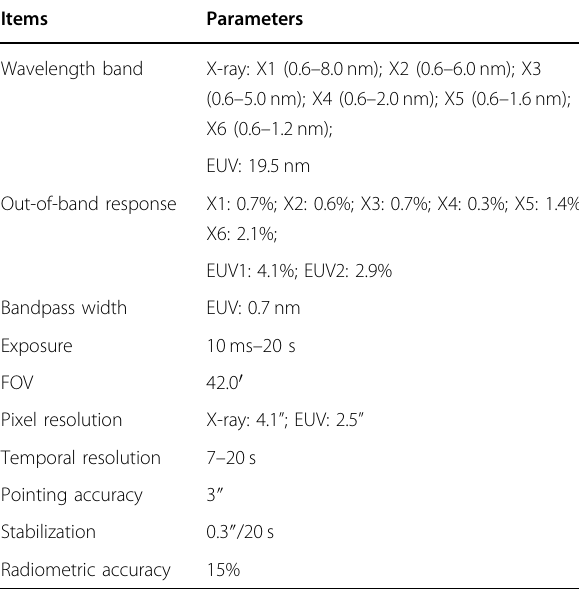
Table 2 Performance parameters of